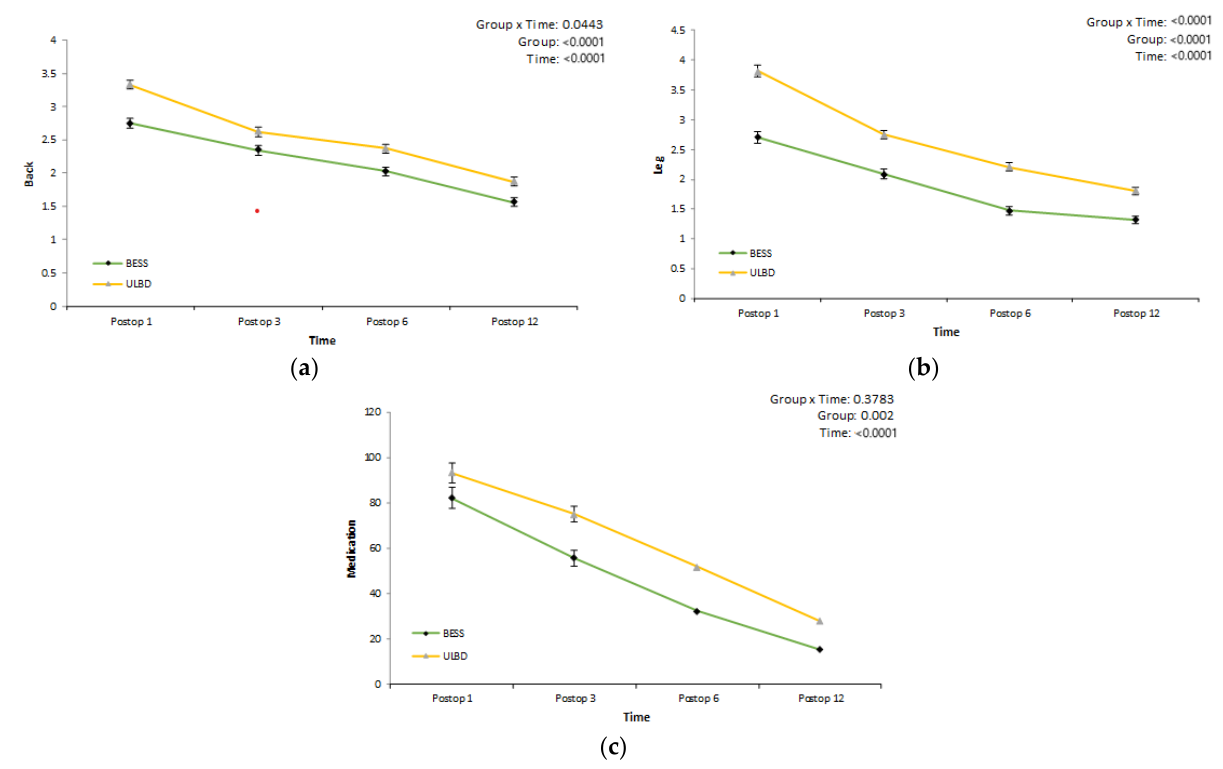
Figure 3. Clinical outcomes: VAS score and medication use by range of levels. Back ( a ); leg ( b ); medication (mg) ( c ). Table 5. Clinical outcomes: ODI change by range of